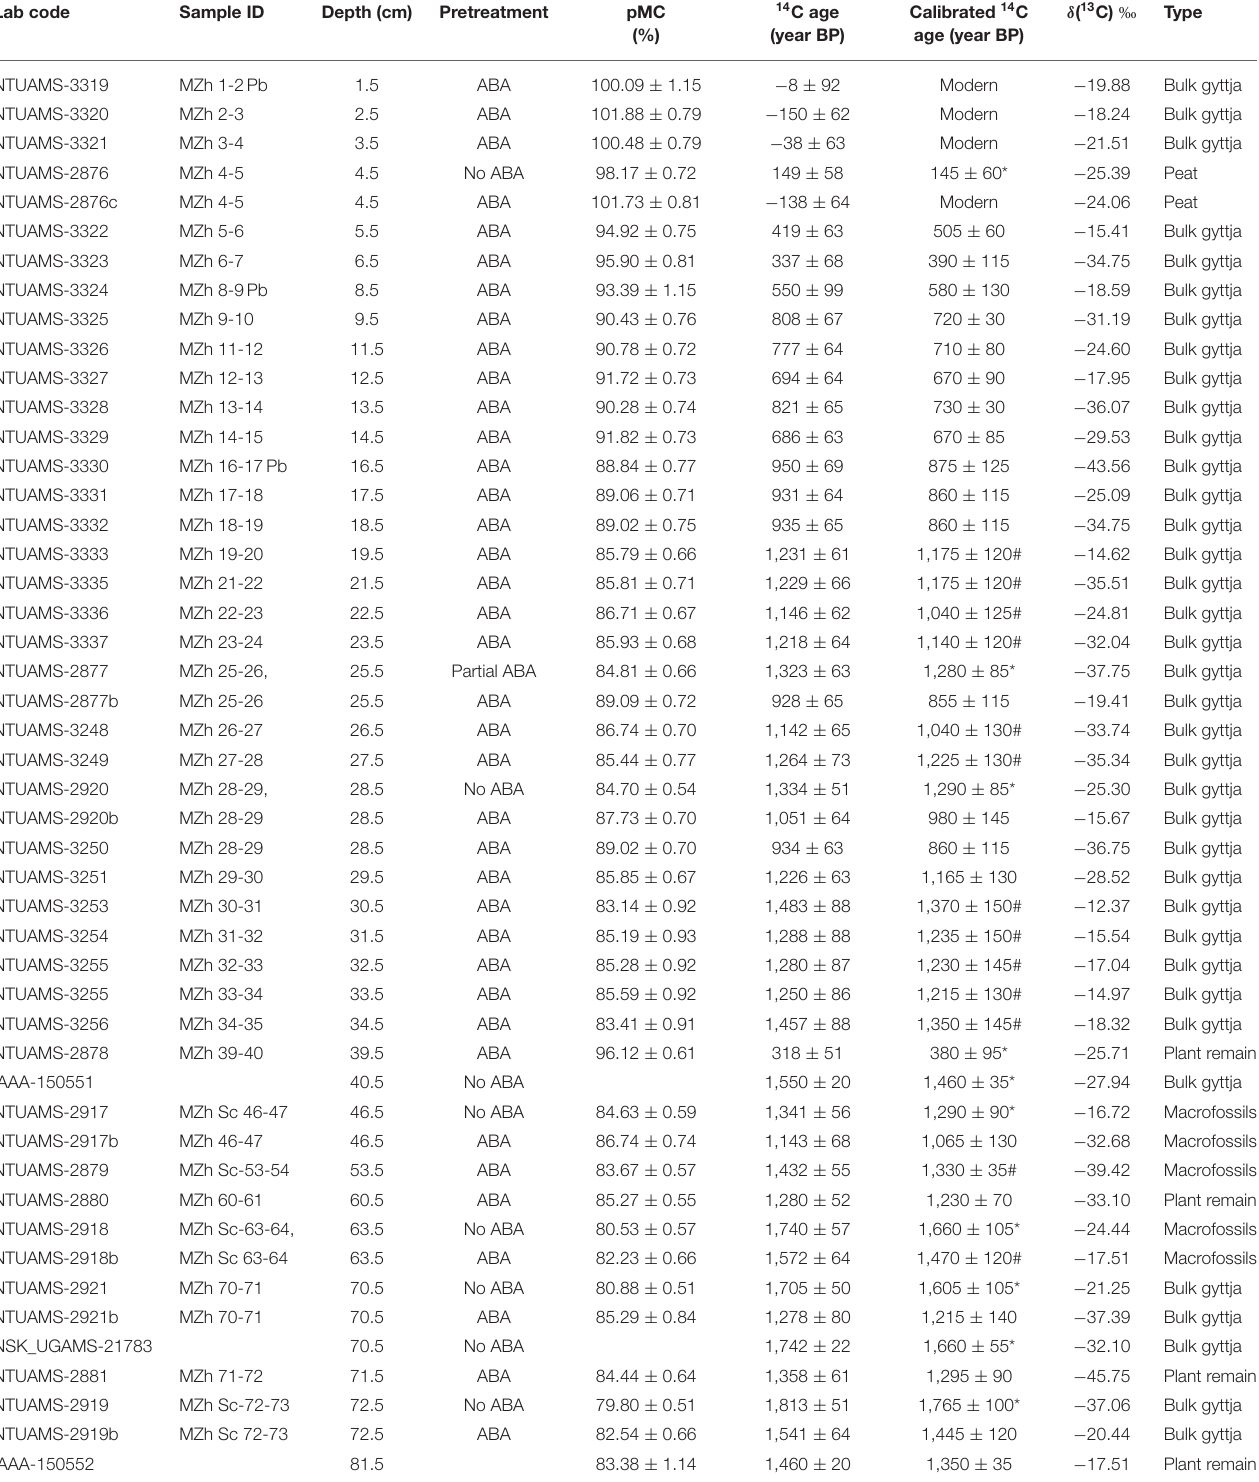
TABLE 1 | Accelerator mass spectrometry 14 C dates of the samples from Manzherok Lake core. Lab